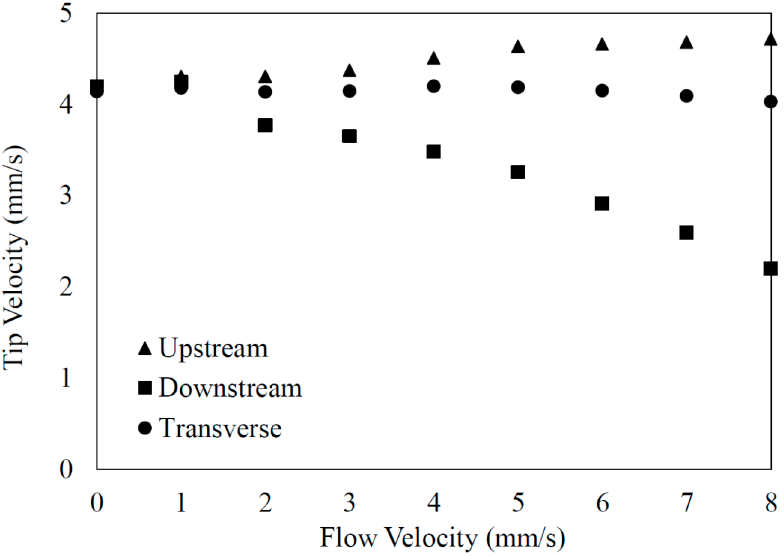
Figure 12. Variation of average tip growth velocity with the velocity of melt for Al-3 wt % Cu alloy with ∆ T = 4.5 °C.